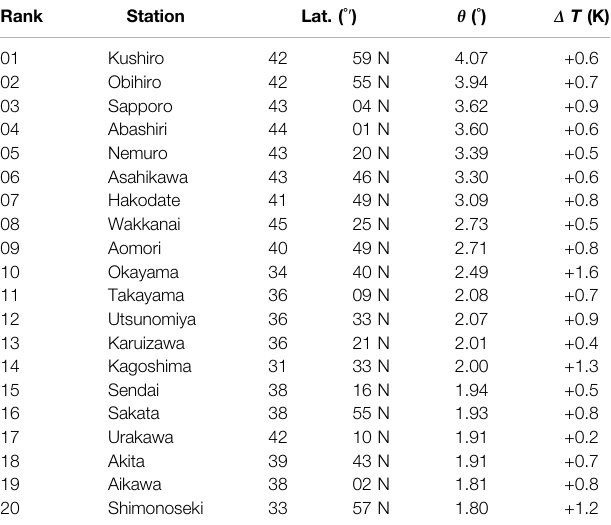
TABLE3B| Top-twentyJapanesestationsintheintersectingangleofthemonthly temperatures from Period II (from 1951 to 1980) to Period III (from 1981 to